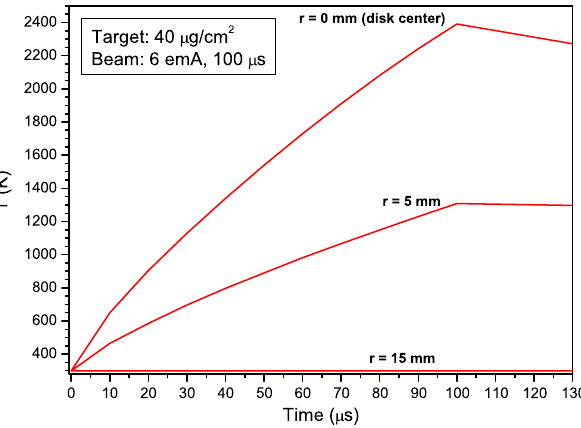
FIG. 8. Linear ion charge distribution along ion trajectory: temperature and internal energy along the beam axis at t ¼ 100 μ s (end of the pulse), solid lines represent exclusion of heat conduction and dashed lines represent inclusion of heat con- duction, foil thickness ¼ 30 μ g = cm 2 , ion current ¼ 6 emA, par- ticle energy ¼ 1 . 4 MeV = u.